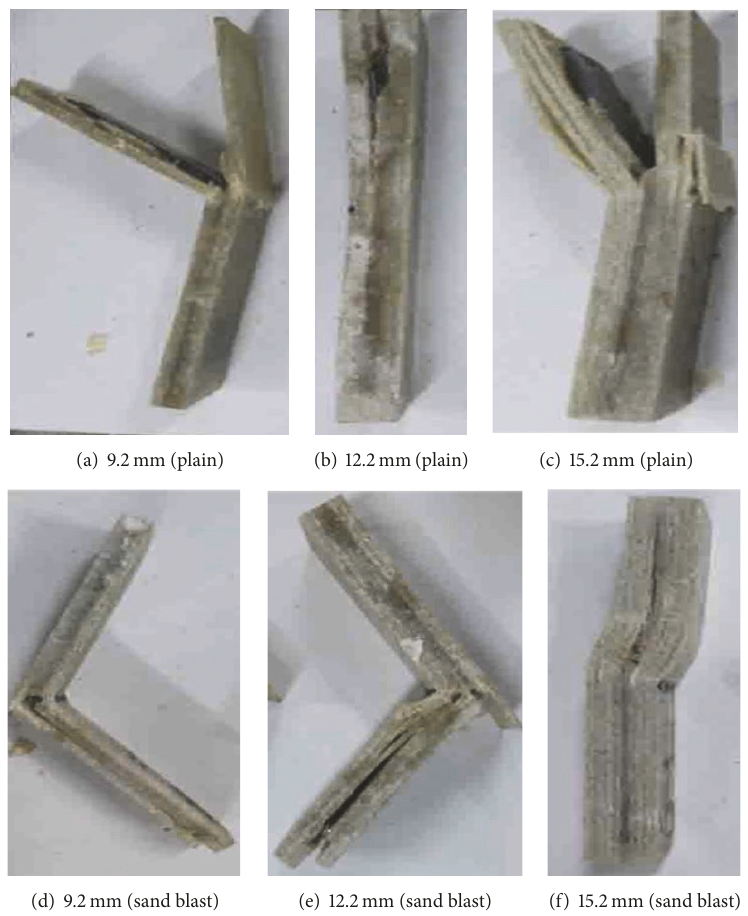
Figure 13: Fracture deformation with thickness of hybrid panels after tap water